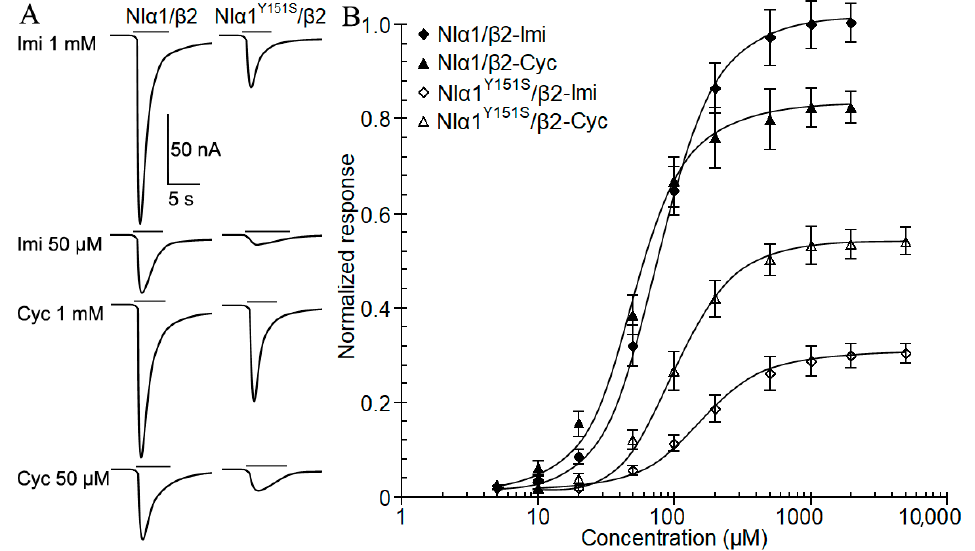
Figure 2. Effects of Y151S mutation on agonist potency on the receptor Nl α 1 Y151S / β 2. ( A ) Representative currents elicited by imidacloprid and cycloxaprid on wildtype receptor Nl α 1/ β 2 (left) and mutant receptor Nl α 1 Y151S / β 2 (right). The concentrations ( µ M) were provided following drug name, imidacloprid (Imi) and cycloxaprid (Cyc). ( B ) Concentration-response curve for inward currents induced by imidacloprid and cycloxaprid ( n = 6–12). The currents were normalized to the maximum currents elicited by 1000 µM imidacloprid on the wildtype receptor Nl α 1/ β 2. Data were presented as mean ± SEM.